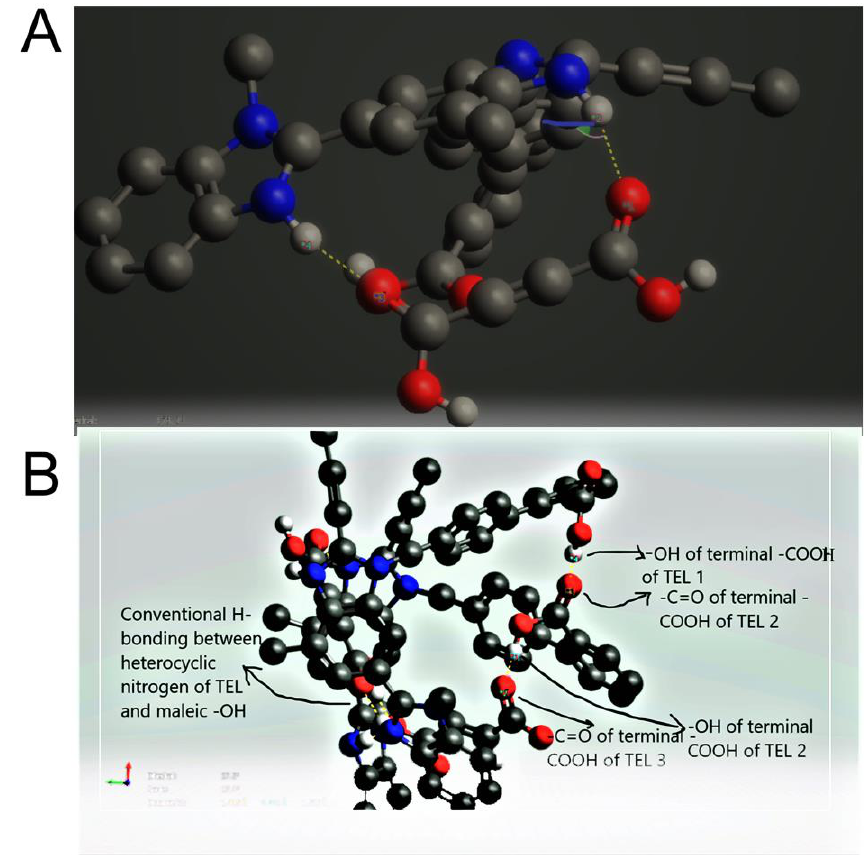
Figure 6. Force of interactions between TEL, MAL and MALION in increasing molar ratio. [(( A ). TEL:MAL:MALION = 1:1:1); (( B ). TEL:MAL:MALION = 2:1:1)].